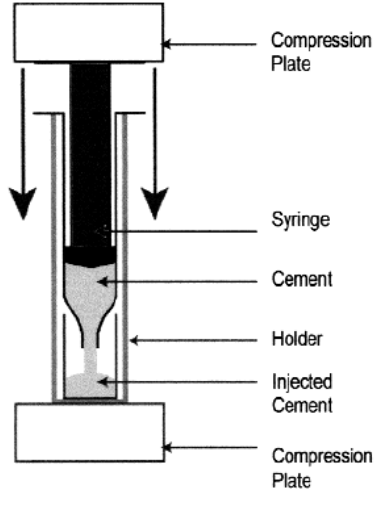
Figure 3. A schematic representation of the experimental setup used to quantify the injectability of the calcium orthophosphate cements. Reprinted from Ref.